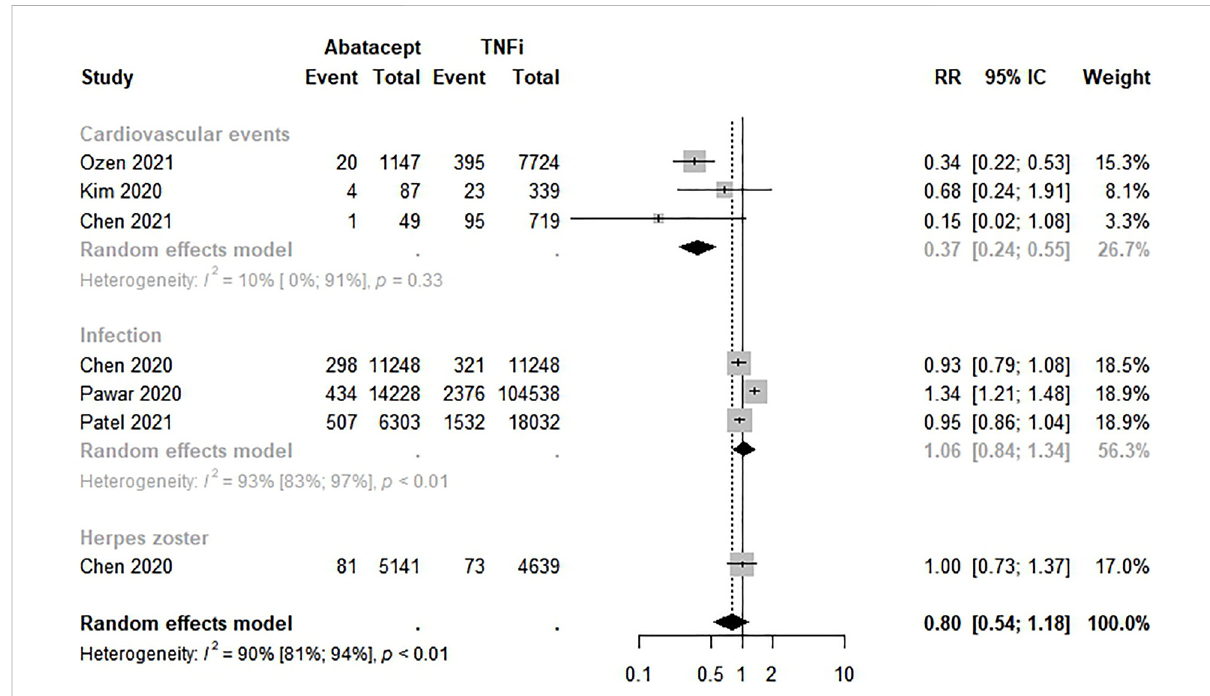
FIGURE 5 Comparative safety of abatacept and biological disease-modifying anti-rheumatic drugs. bDMARD: biological disease-modifying anti- rheumatic drugs.